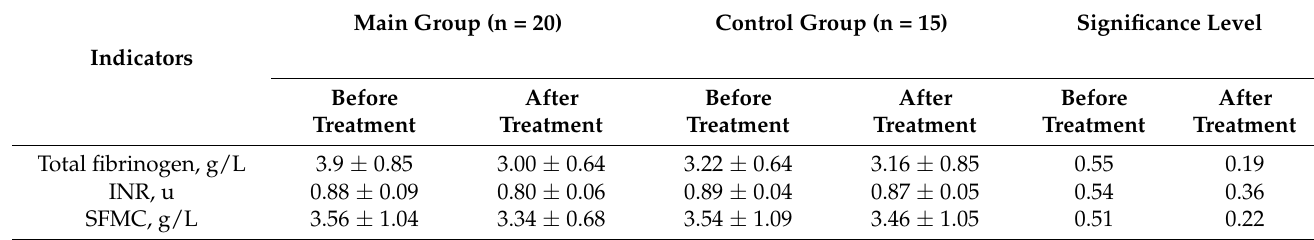
Table 5. Blood coagulation properties of patients with peripheral atherosclerosis during